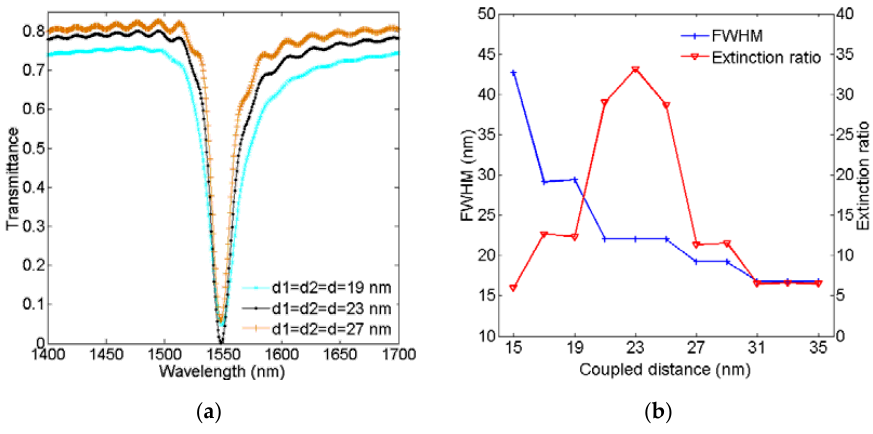
Figure 6. ( a ) Transmission spectra for d = 19 nm, 23 nm, and 27 nm; ( b ) FWHM and extinction ratio as a function of coupled distance d .